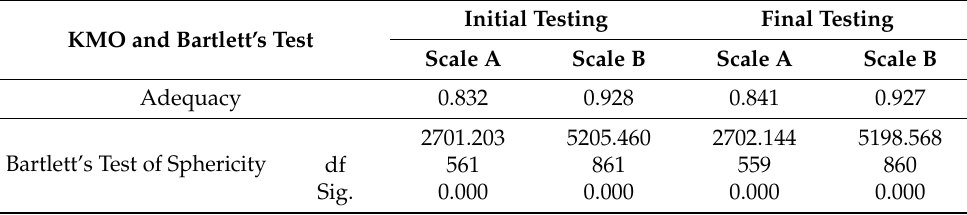
Table 2. Values of KMO and Bartlett’s Test per subscale, PKBS